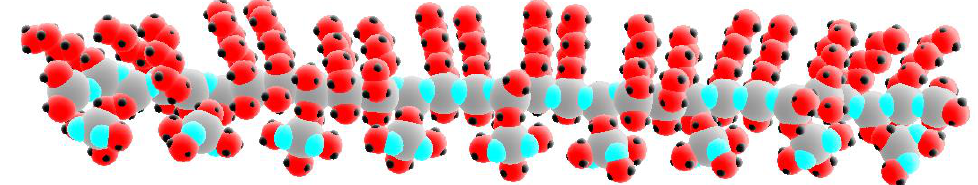
Figure 1. Structure of the linear modifier (double-functionalized polymethylhydrosiloxane (PMHS)).